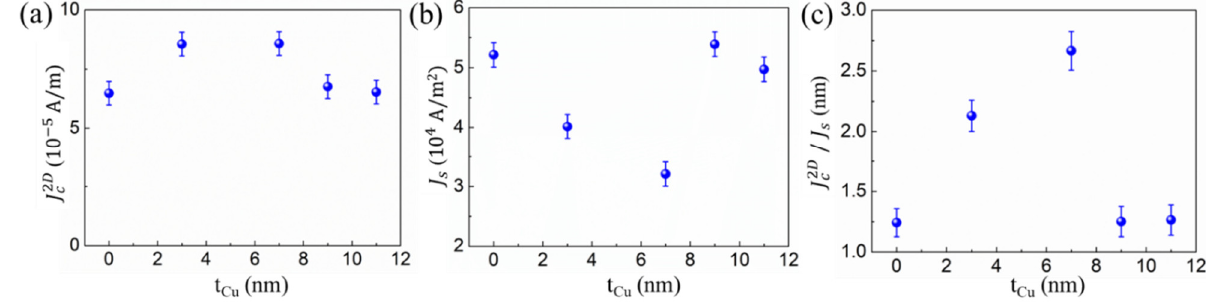
Figure 3. ( a )   vs. t Cu ; ( b ) J s vs t Cu ; ( c )   /J s vs. t Cu measured at 3GHz excitation frequency. Figure 3. ( a ) J 2 D c vs. t Cu ; ( b ) J s vs. t Cu ; ( c ) J 2 D c /J s vs. t Cu measured at 3GHz excitation frequency. Figure 3a plots the J 2 D versus t Cu . There is an optimized J 2 D c